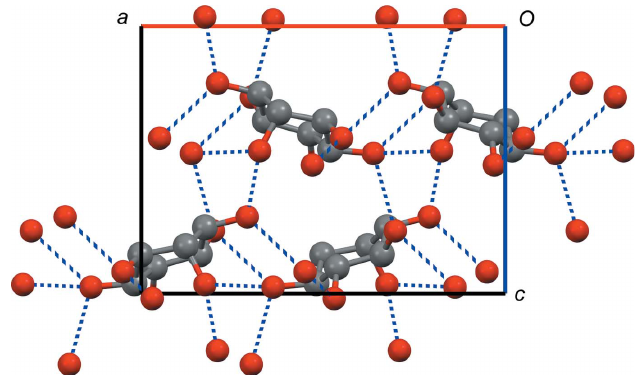
Figure 21 Crystal structure of 7 -C. Space group Pca 2 1 , view along the b axis ( a axis shown in red, c axis shown in blue). Hydrogen bonds are indicated as dashed blue lines, H atoms have been omitted for